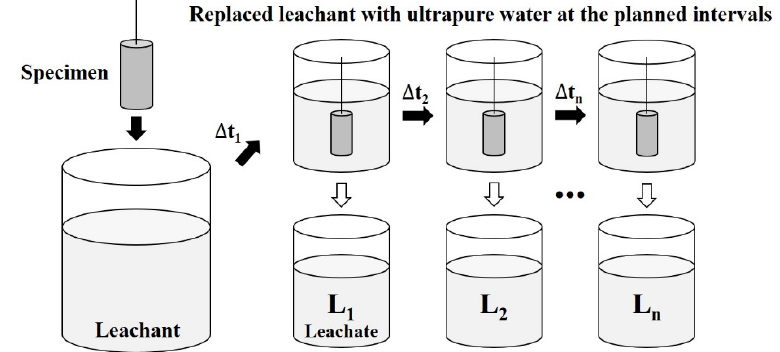
Figure 1. Schematic diagram of the leaching test according to ANS 16.1.